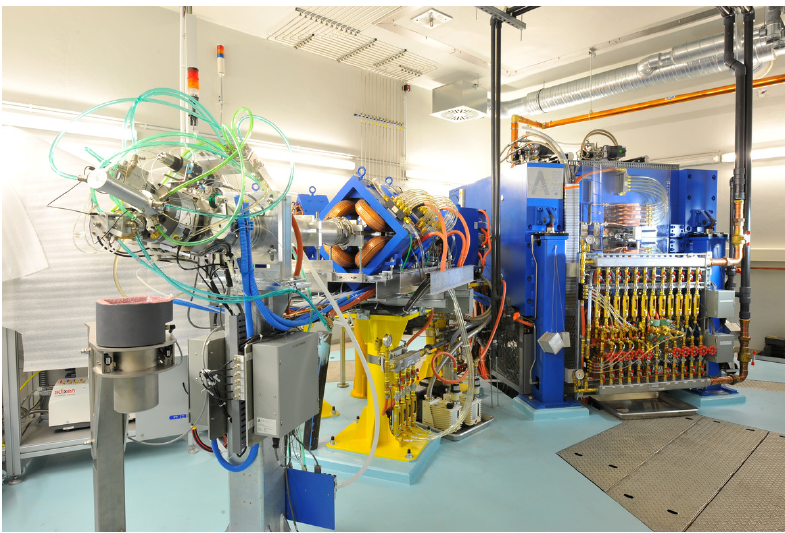
Figure 3. The TR-Flex cyclotron at the HZDR. The beamline 1B with a 4-port target selector is shown in the foreground. The second 4-port target selector is at the opposite side of the Cyclotron. Picture: HZDR/Frank Bierstedt.